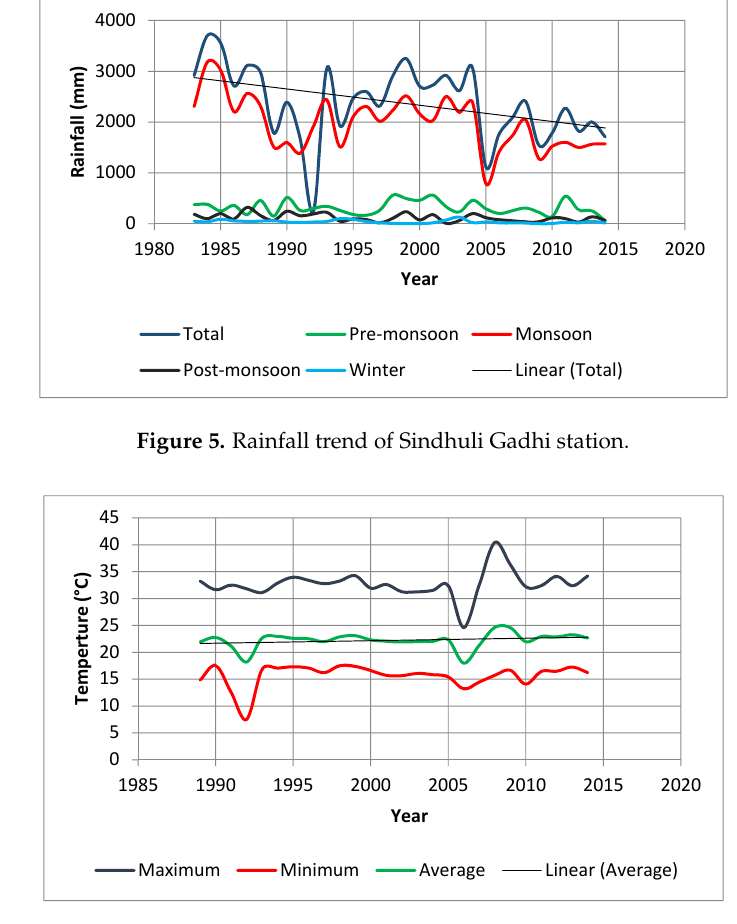
Figure 7. Rainfall trend of Udayapur Gadhi station. Figure 8. Temperature trend of Udayapur Gadhi station.